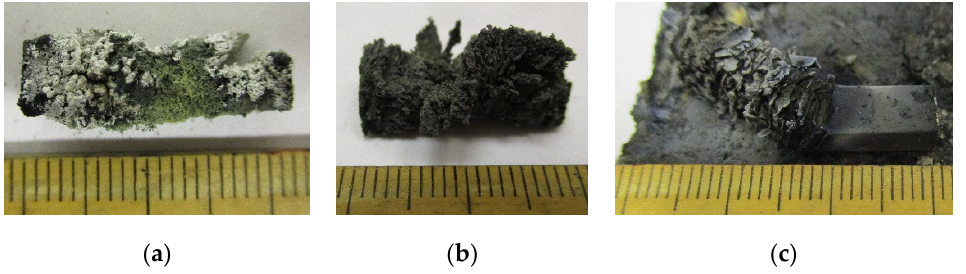
Figure 8. Video frames of the combustion in the W/PTFE/Al system, time (s): ( a , d , g , j ) air ( b , e , h , k ) argon, ( c , f , i , l ) vacuum.